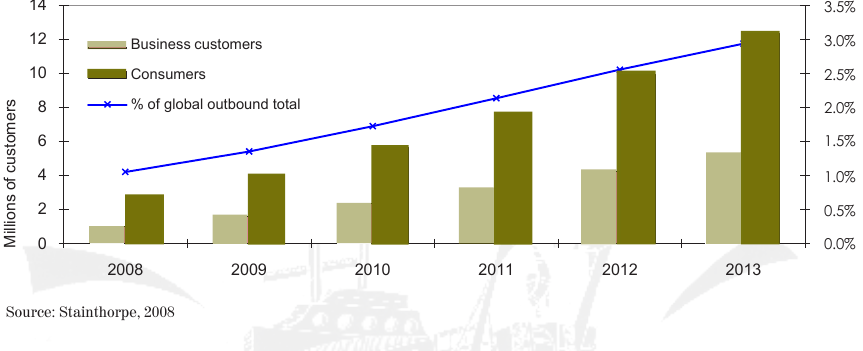
FIGURE 3: FORECAST OF TOTAL OUTBOUND ROAMERS FROM AFRICAN MNOS